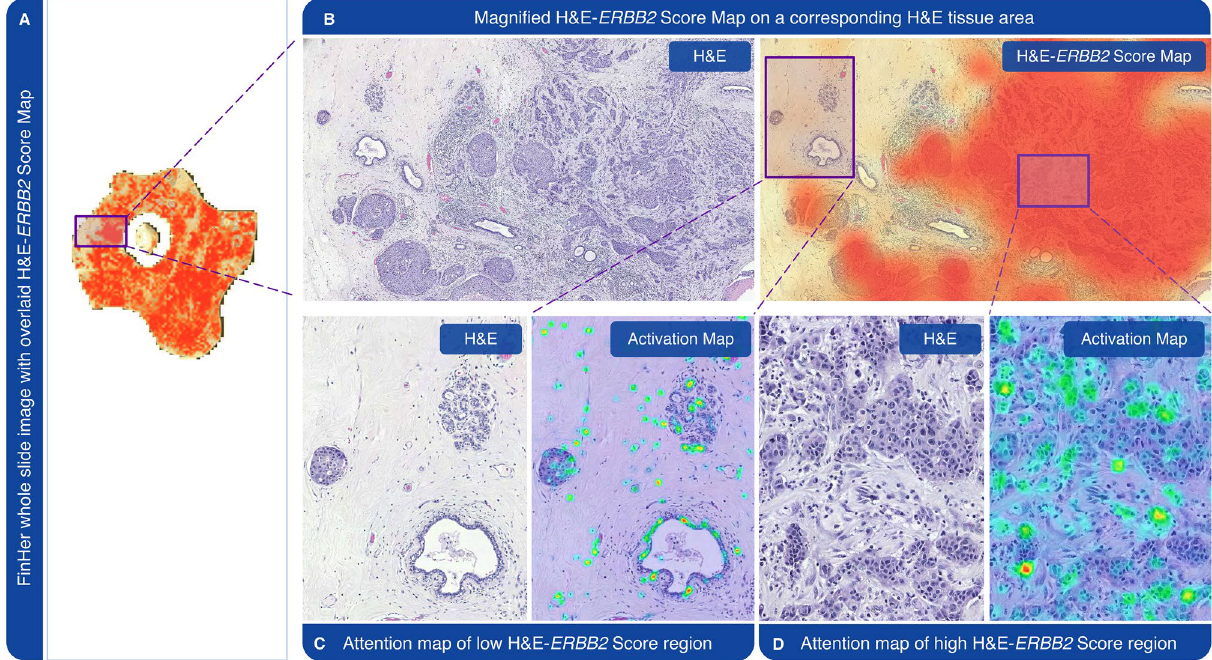
Figure 4. H&E- ERBB2 score and Grad-CAM activation maps. ( A ) H&E- ERBB2 Score Map as predicted by the convolutional neural network (CNN) based on a hematoxylin eosin (H&E) stained sample from the FinHer cohort. The Score Map was overlaid as a heatmap on top of the H&E-stained whole-slide tissue image, representing variable levels of the CNN-derived H&E- ERBB2 score. ( B ) Left: Magnified image of the box shown in panel A. Right: Areas representing high H&E- ERBB2 Scores indicated with red. ( C ) Grad-CAM activation map of a region predicted to have a low H&E- ERBB2 score. ( D ) Grad-CAM activation map of a region with a high H&E- ERBB2 score. The high score areas indicate clusters of cancerous epithelial cells. The sample presented is ERBB2 -positive by chromogenic in situ hybridization and had a high overall H&E- ERBB2